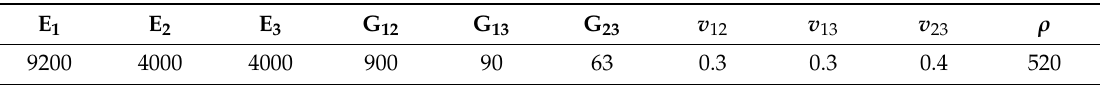
Table 2. Material Properties of CLT collected from the literature. Stiffness parameters have the unit of MPa, Poisson ratios are dimensionless, and the density is given in kg/m 3